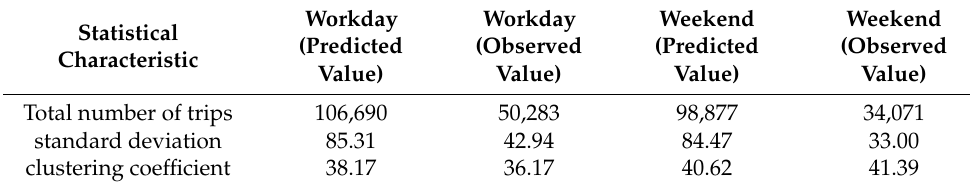
Table 1. Statistical characteristic of predicted and observed value.